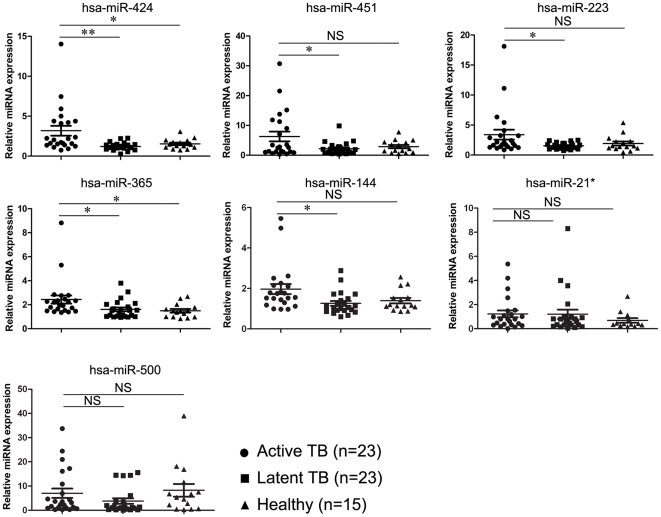
Quantitative PCR (qPCR) validation of miRNA expression levels in samples from the active tuberculosis (TB) group versus the latent tuberculosis infection (LTBI) groups.We confirmed the gene expression levels of miRNAs using real-time qPCR. We analyzed the expression of 7 miRNAs (hsa-miR-223, hsa-miR-365 hsa-miR-424, and hsa-miR-451, hsa-miR-144, hsa-miR-500 and hsa-miR-21*) selected from the microarray data by qPCR. The 2−ΔΔCT method was used to normalize the relative gene expression data in the qPCR assay. U6 snRNA was set as the reference gene. The miRNA expression value in one subject with LTBI was normalized to 1. Statistical analysis was performed using the unpaired t-test. ** P<0.01, * P<0.05, NS: not significant.